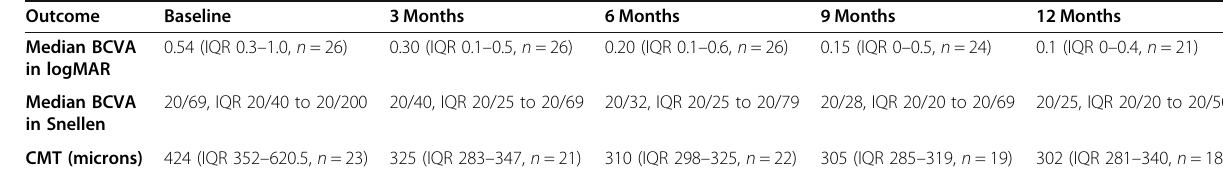
Table 3 Median Visual Acuity and Central Macular Thickness (CMT) Over 12 Months Follow-Up Outcome Baseline